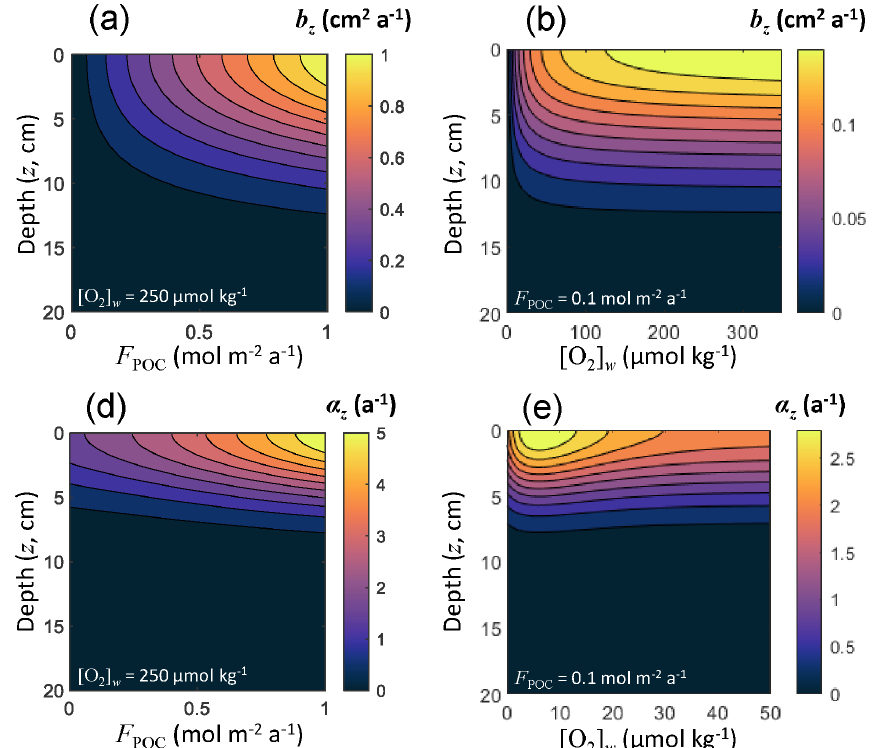
Figure 3. Bioturbation mixing rate b z and irrigation coefficients α z as a function of sediment depth z , organic carbon deposition flux F POC , and dissolved oxygen concentration in the bottom waters [O 2 ] w